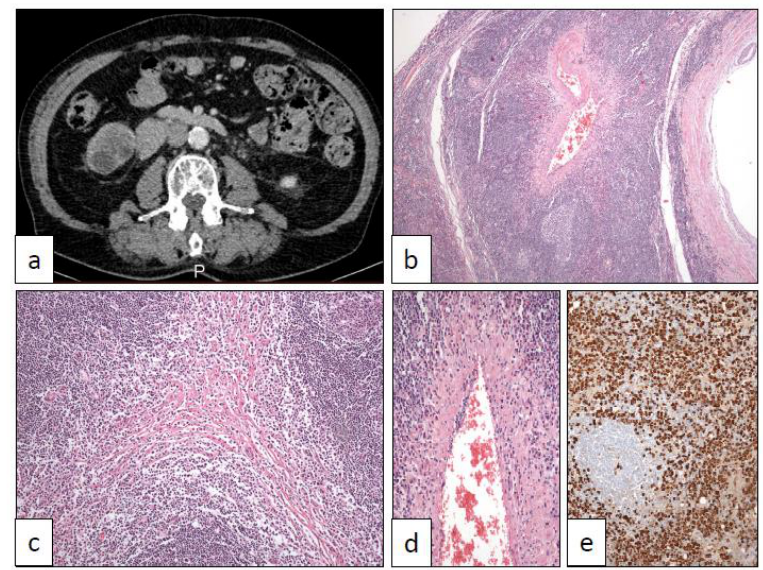
Figure 4. IgG4-related disease showing a tumor mass in the right ureter in CT scan ( a ) affecting ureter wall and periureteral soft tissues with a dense lymphoplasmacytic infiltrate (10×) ( b ) and displaying the typical storiform-type fibrosis (40×) ( c ), phlebitis (100×) ( d ), and dense IgG4 subpopulation higher than 40% (250×) ( e ).